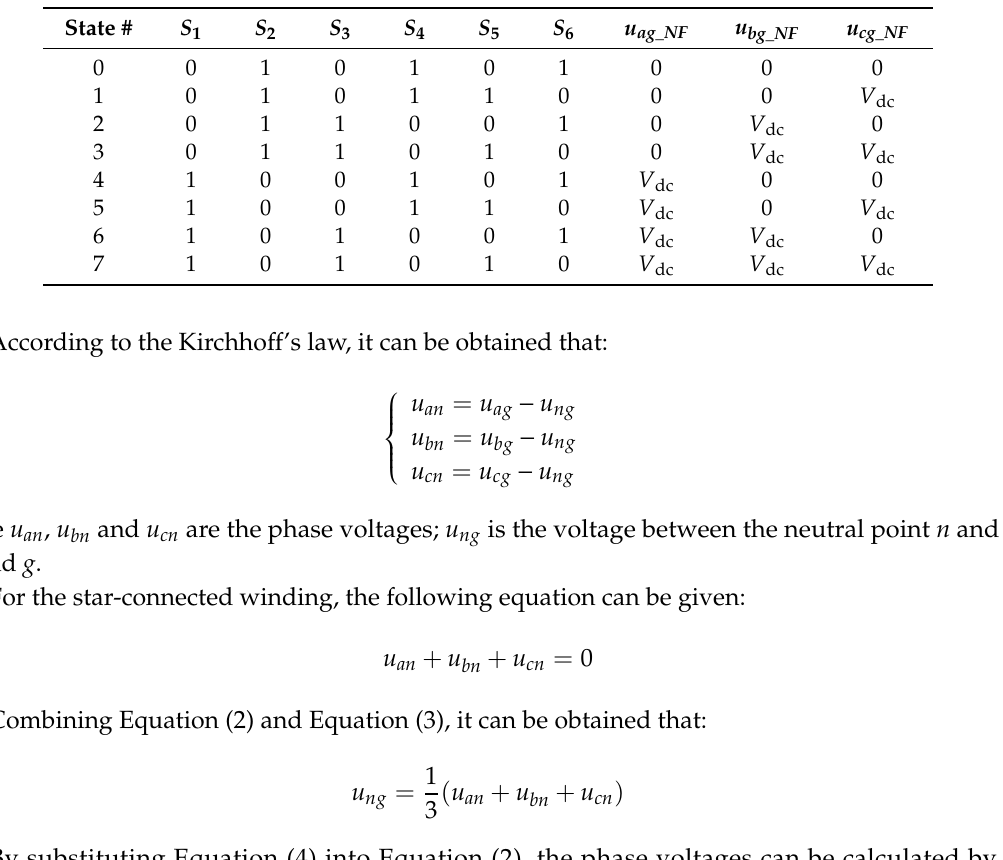
Table 1. The relationship between switching states and the winding-to-ground voltages under healthy